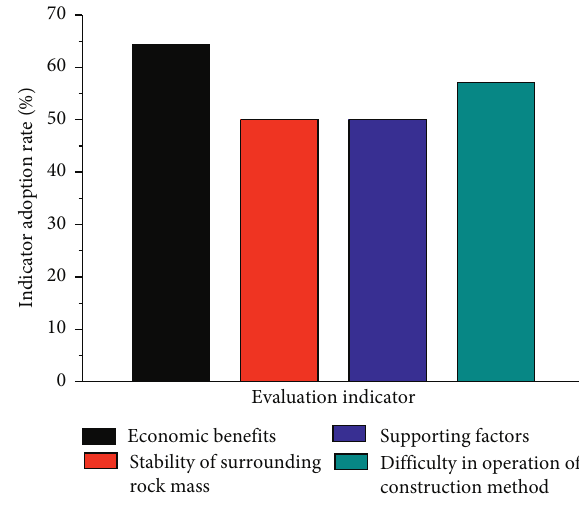
Figure 5: Very important qualitative indices (5